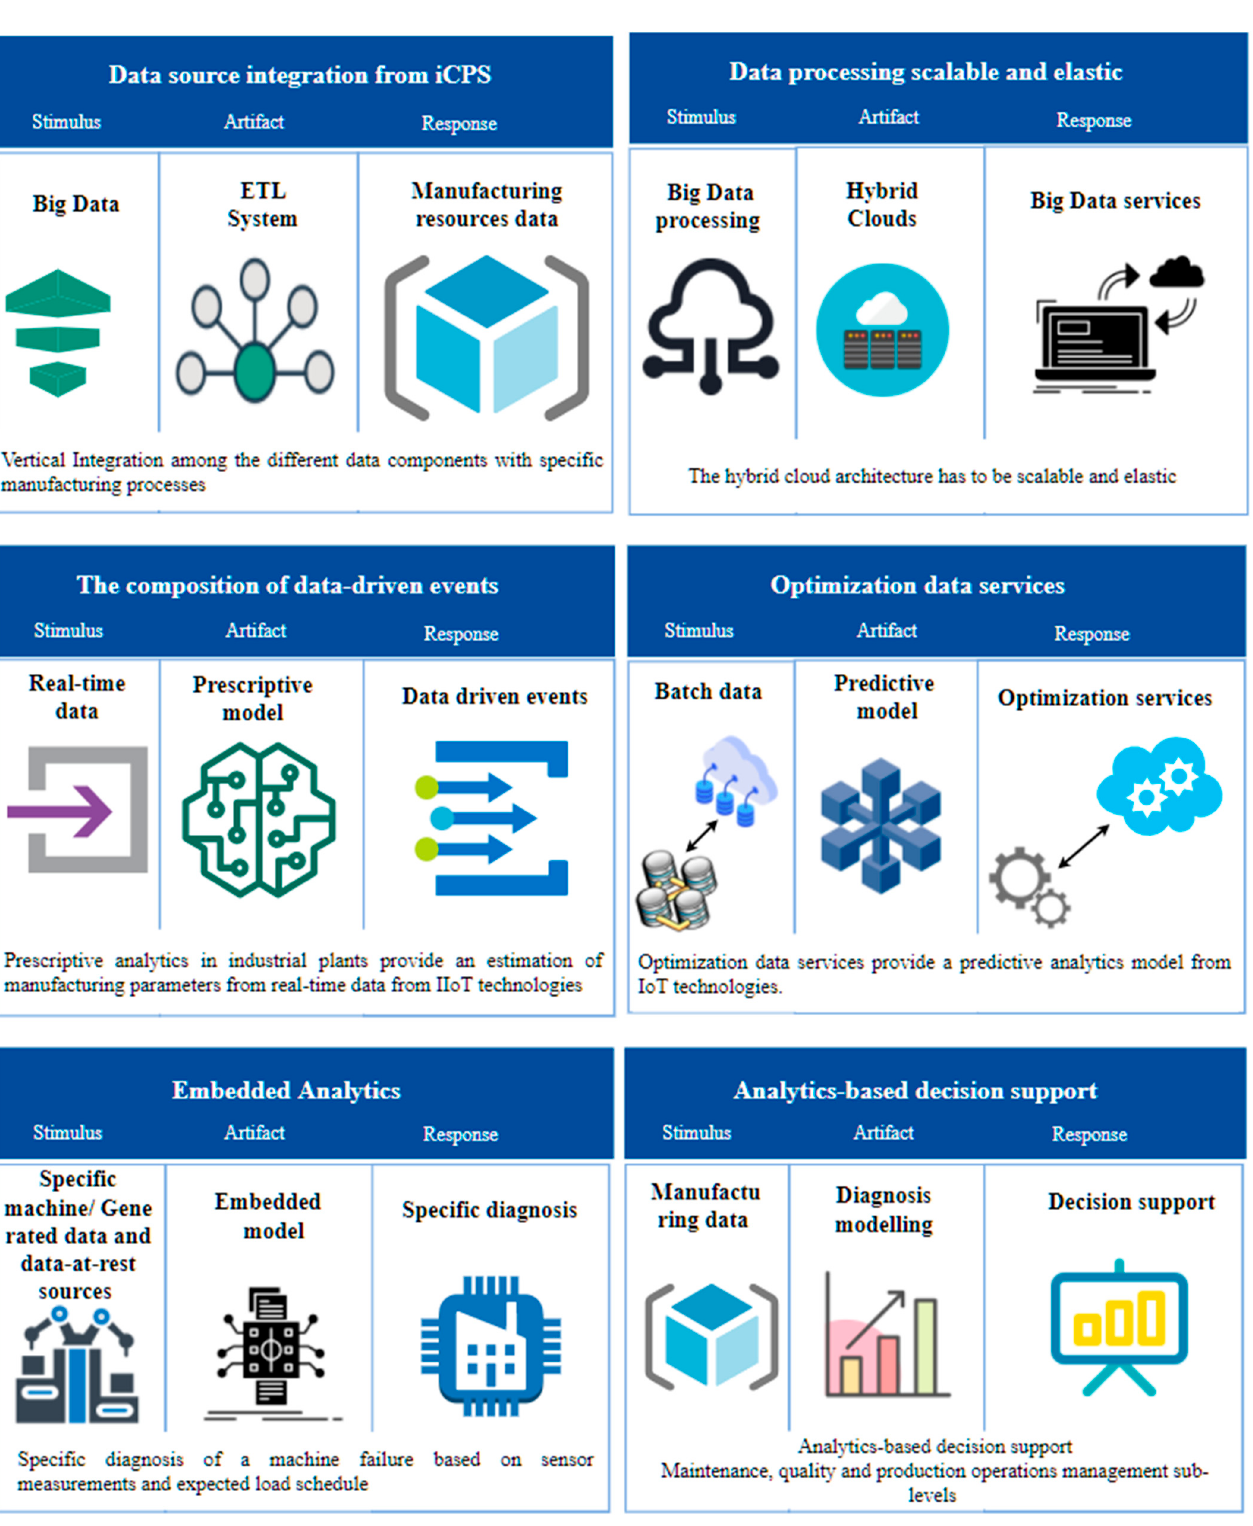
Figure 6. Scenario definition. (Graphics source: https://online.visual-paradigm.com/, accessed date: 14 June 2021).